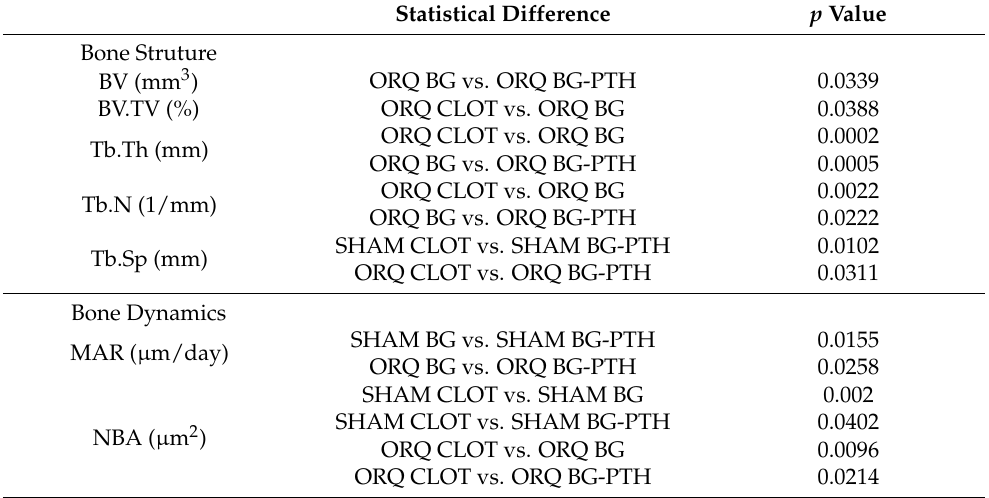
Figure 2. Micro-CT analyses. ( A ) Bone volume (BV). ( B ) Percentage of bone volume (BV/TV). ( C ) Trabecular thickness (Tb.Th). ( D ) Trabecular number (Tb.N). ( E ) Trabecular separation (Tb.Sp). ( F ) Total Porosity (Po(tot)). Asterisks (*,**,***) denote intragroup statistical difference ( p < 0.05). The intergroup difference can be seen in Table 1. Table 2. Representation intragruop of the statistically significant difference between SHAM vs. SHAM (CLOT, BG and BG-PTH) and ORQ vs. ORQ (CLOT, BG and BG-PTH) for bone structure (BV, BV.TV, Tb.Th, Tb.N, Tb.Sp and Po(tot)) and bone dynamics (MAR and NBA), indicate significance at p < 0.05.